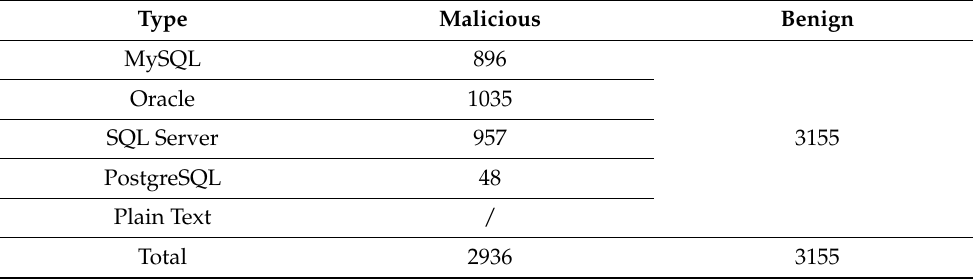
Table 3. Statistical information of various database